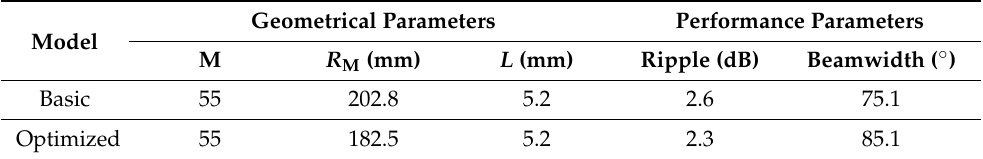
Table 2. Comparison between basic and optimized models for the M-subarray part.